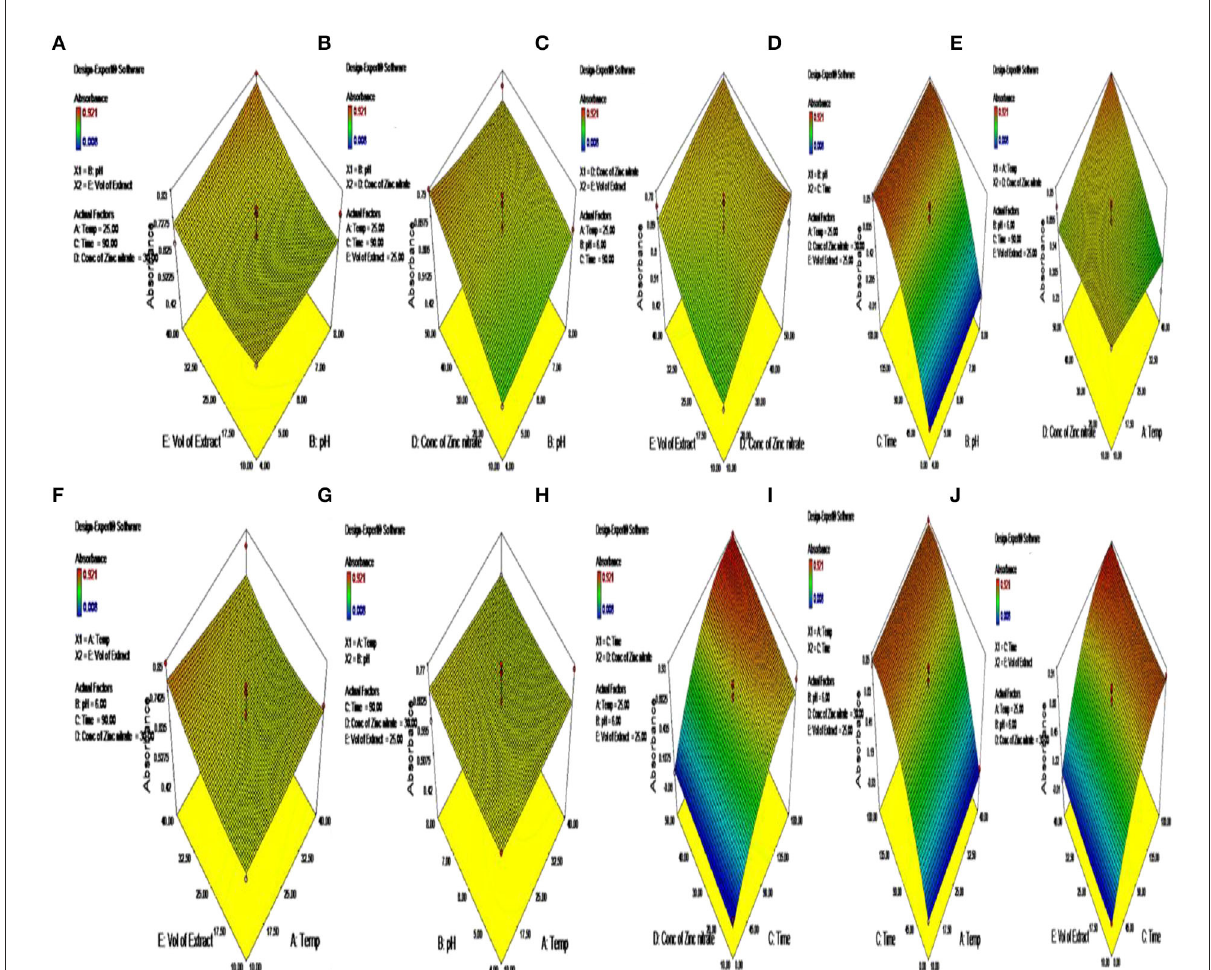
FIGURE2 (A–J) Optimization of parameters for the synthesis of green-synthesized ZnO by C. ternatea